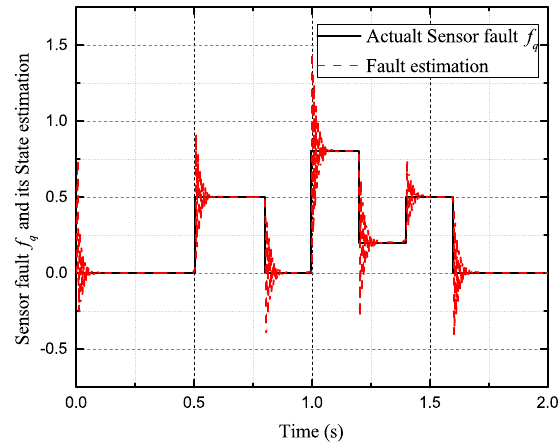
Figure 14. Sensor fault f q and its estimated value ˆ f q .